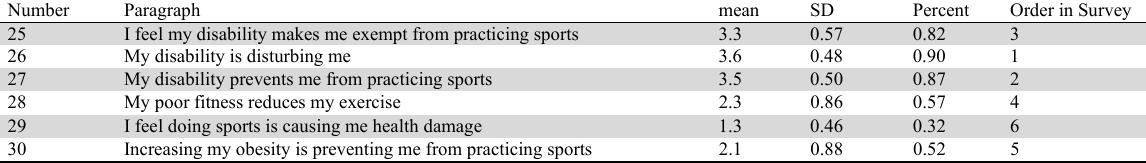
Arithmetic mean, standard deviation and relative importance of the Tool's fourth area of